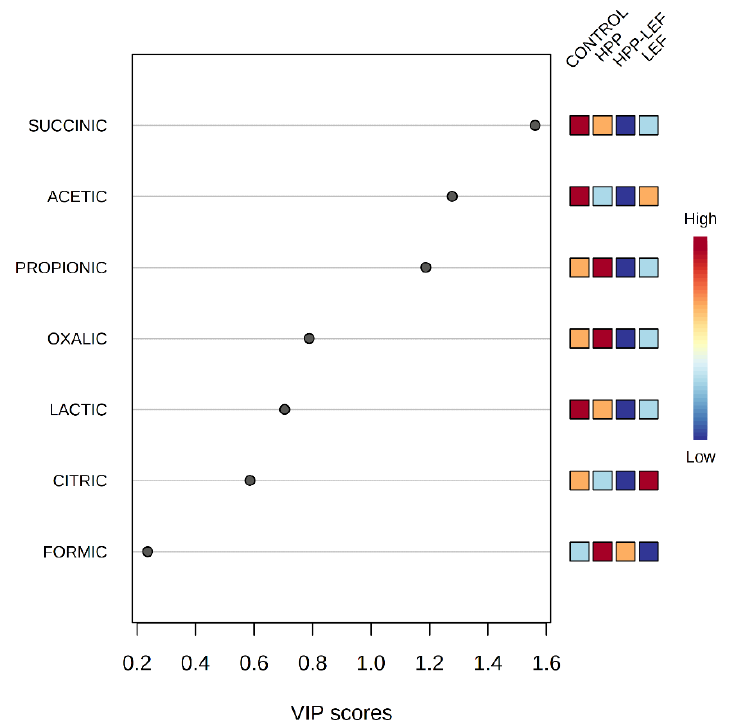
Figure 4. Important features identified by partial least squares-discriminant analysis (PLS-DA) from cheese samples stored at 4 ◦ C under the 4 different treatments (control, HPP, LEF and HPP-LEF). The color scale on the right represents the scaled abundance of each variable, with red-colored boxes indicating high abundance and blue-colored boxes indicating low abundance.